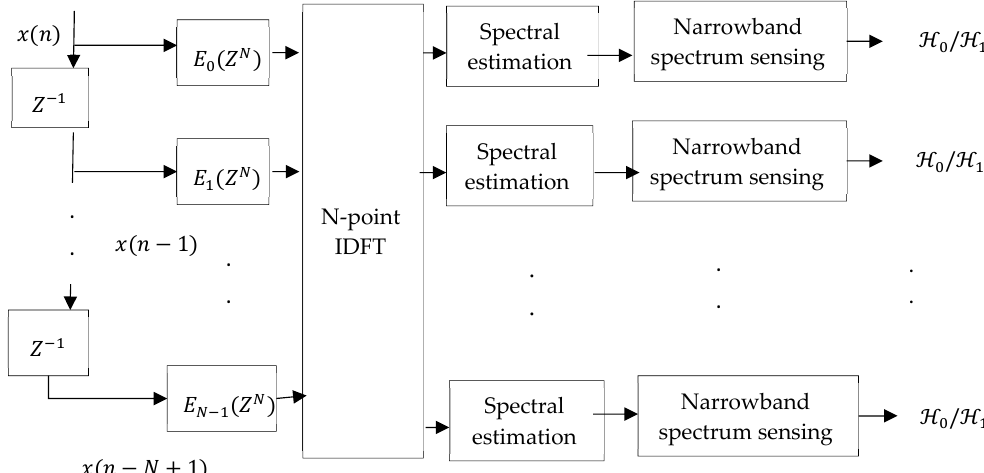
Figure 8. Block diagram of filter bank based spectrum sensing [79–82].